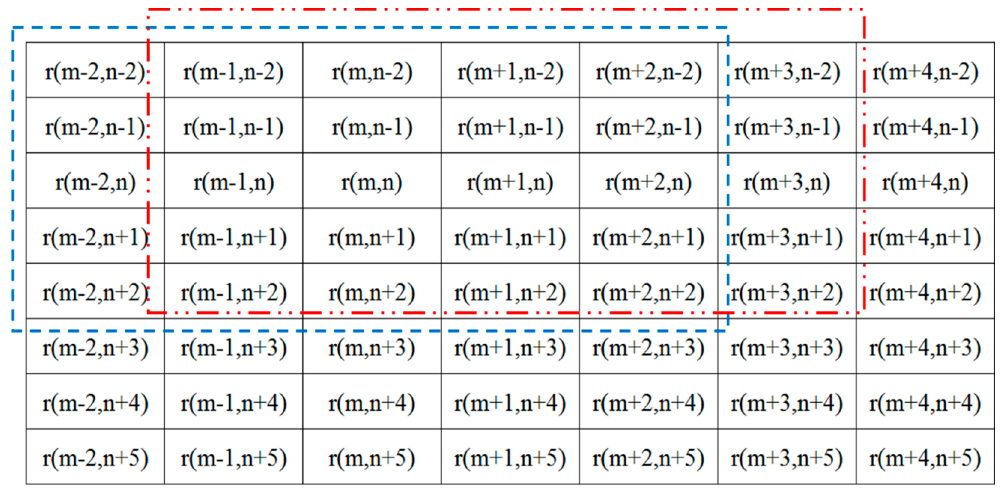
Figure 3. Sliding window matrices of r ( m,n ) and r ( m+1,n ) .